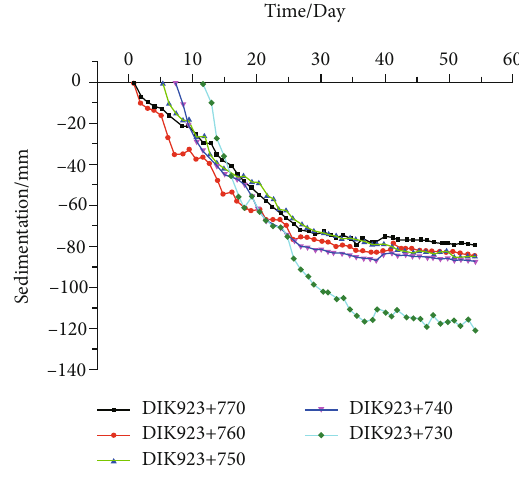
Figure 10: Settlement curve of